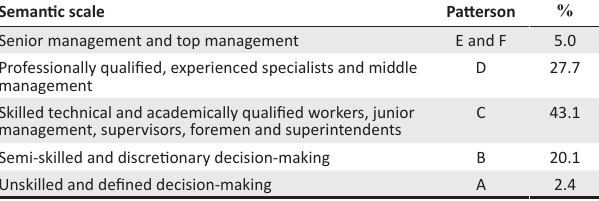
TABLE 4: The correlation between Corporate Entrepreneurship Assessment Instrument scores and innovative behaviour in the workplace. Corporate entrepreneurship